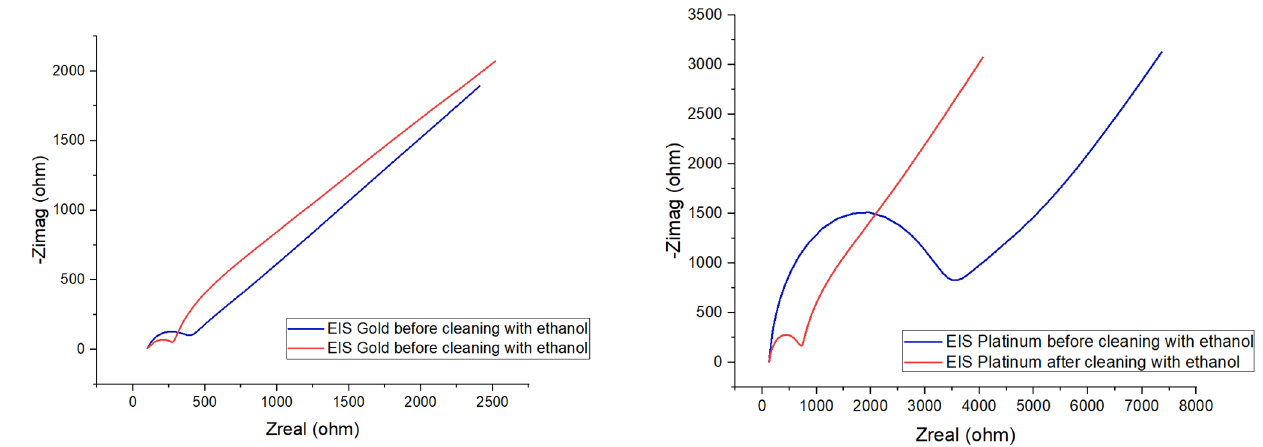
Figure 6. EIS of the gold and platinum electrodes before and after cleaning with ethanol: blue-EIS before cleaning; red-EIS after cleaning. Created with OriginPro.